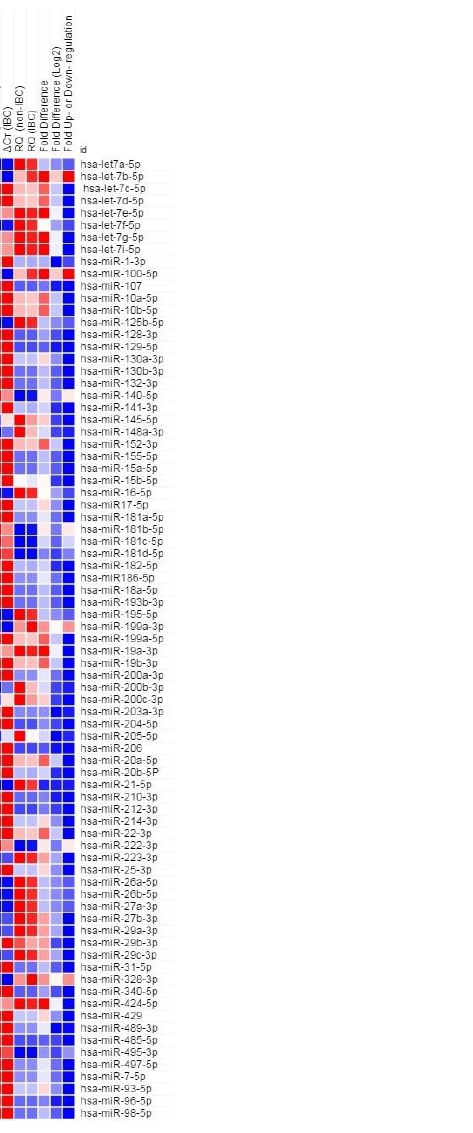
Figure 1. Aberrant expression of microRNA (miRNA) patterns in primary carcinoma tissue specimens of inflammatory breast cancer (IBC) vs. non-IBC. Assisted by the miScript miRNA PCR array, the expression levels of 84 miRNAs were profiled. The heat map shows 79 di ff erentially expressed miRNAs with a Ct less than 35 for 9 pooled sample of IBC as opposed to 9 pooled samples of non-IBC. Data are expressed as log2 and were analyzed, and the heat map was generated using web-based software (http: // pcrdataanalysis.sabiosciences.com / mirna / arrayanalysis.php) and